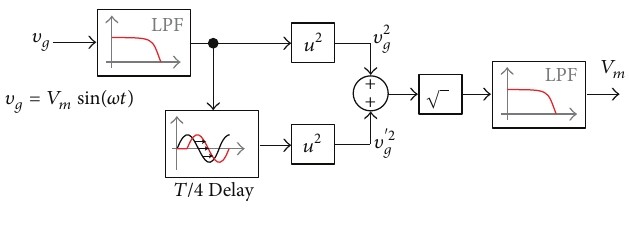
Figure 5: Voltage sag detection by monitoring the peak value based on T /4 Delay orthogonal system.